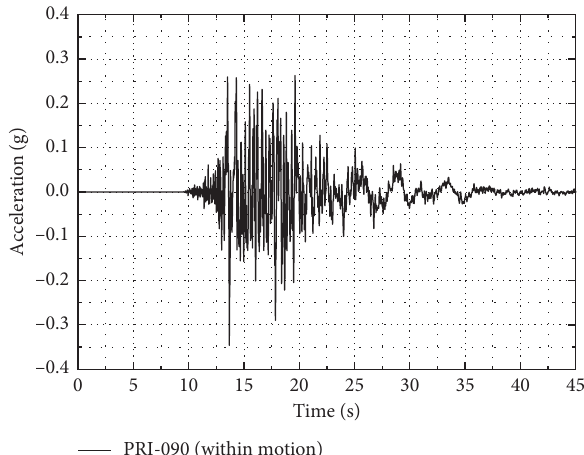
Figure 12: Input motions at the depth of 83m: PRI-090.